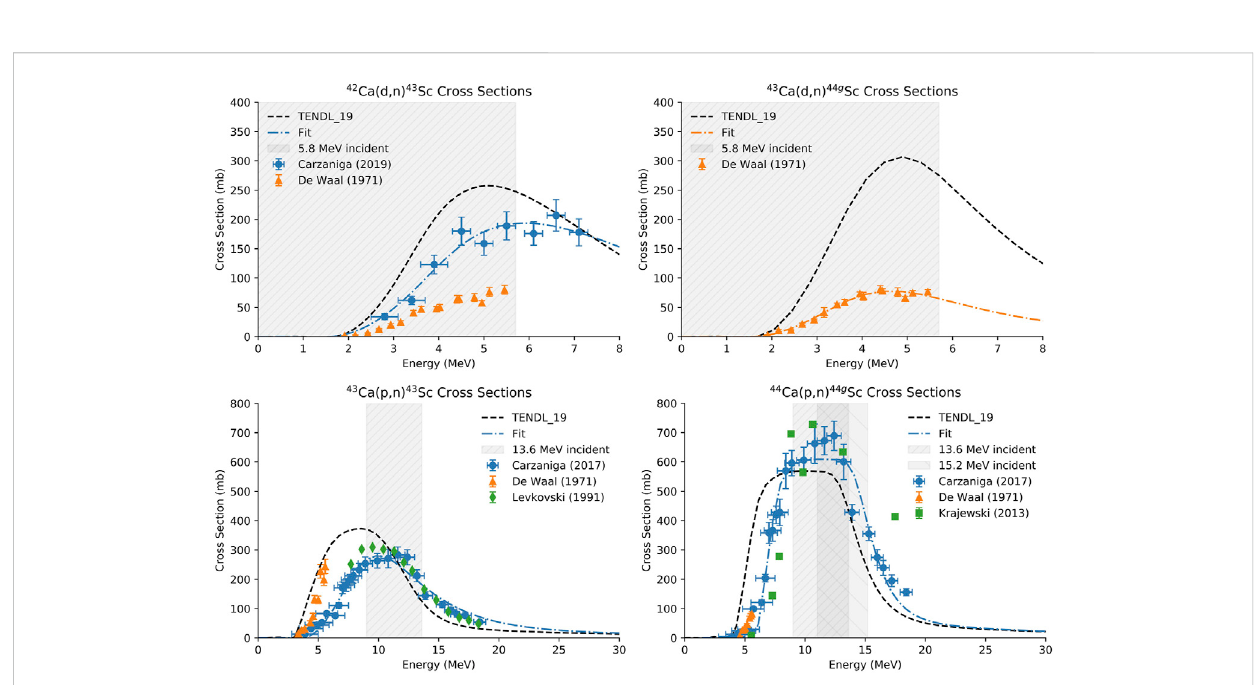
FIGURE 2 Cross sections for the 42 Ca(d,n) 43 Sc, 43 Ca(d,n) 44g Sc (top) (Carzaniga, et al., 2019; de Waal, et al., 1971a; Koning et al., 2012; de Waal, et al., 1971), 43 Ca(p,n) 43 Sc, and 44 Ca(p,n) 44g Sc (bottom) reactions. The energy range investigated is highlighted in gray and a fi t of the experimental data is shown in